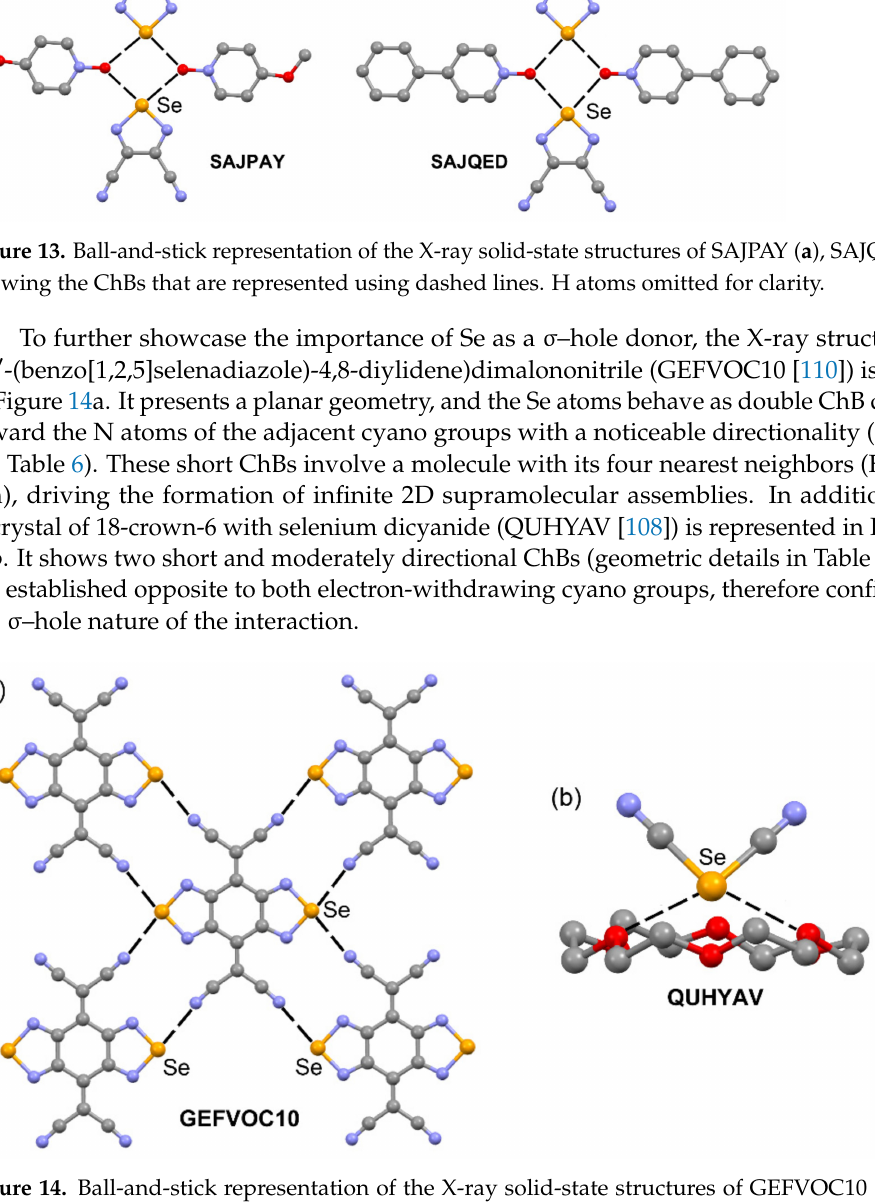
Figure 14. Ball-and-stick representation of the X-ray solid-state structures of GEFVOC10 ( a ) and QUHYAH ( b ). The ChBs are represented using dashed lines. H atoms omitted for